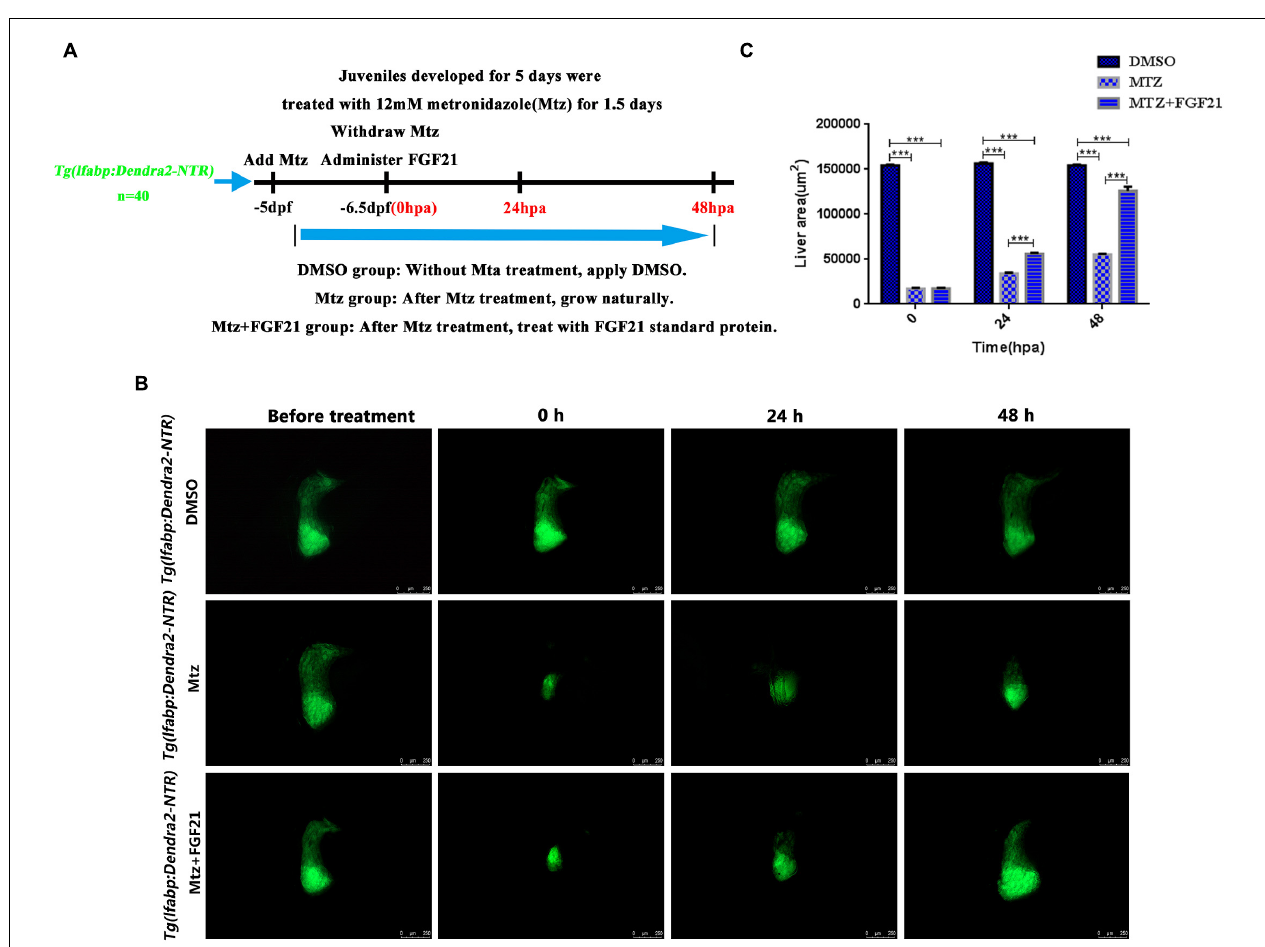
FIGURE 1 | Fibroblast growth factor 21 improves liver regeneration after induced injury. After establishing the liver targeted-ablation model, FGF21 was administered and the treatment effect was evaluated. (A) The overall experimental process of FGF21 therapy for targeted liver ablation. (B) Liver regeneration at several time points after FGF21 treatment of the targeted ablated liver. (C) The histogram shows the quantification of the regenerated liver area assessed by ImageJ. DMSO group: without Mtz treatment, DMSO was applied. Mtz group: after Mtz treatment, the growth is natural Mtz+FGF21 group: after Mtz treatment, they were treated with FGF21 standard protein. Significance: *** p < 0.001 vs. DMSO group. Data are expressed as mean ± standard error of mean (SEM) ( n = 40 per group, repeat 3 times for each test). Scale bar = 250 µ